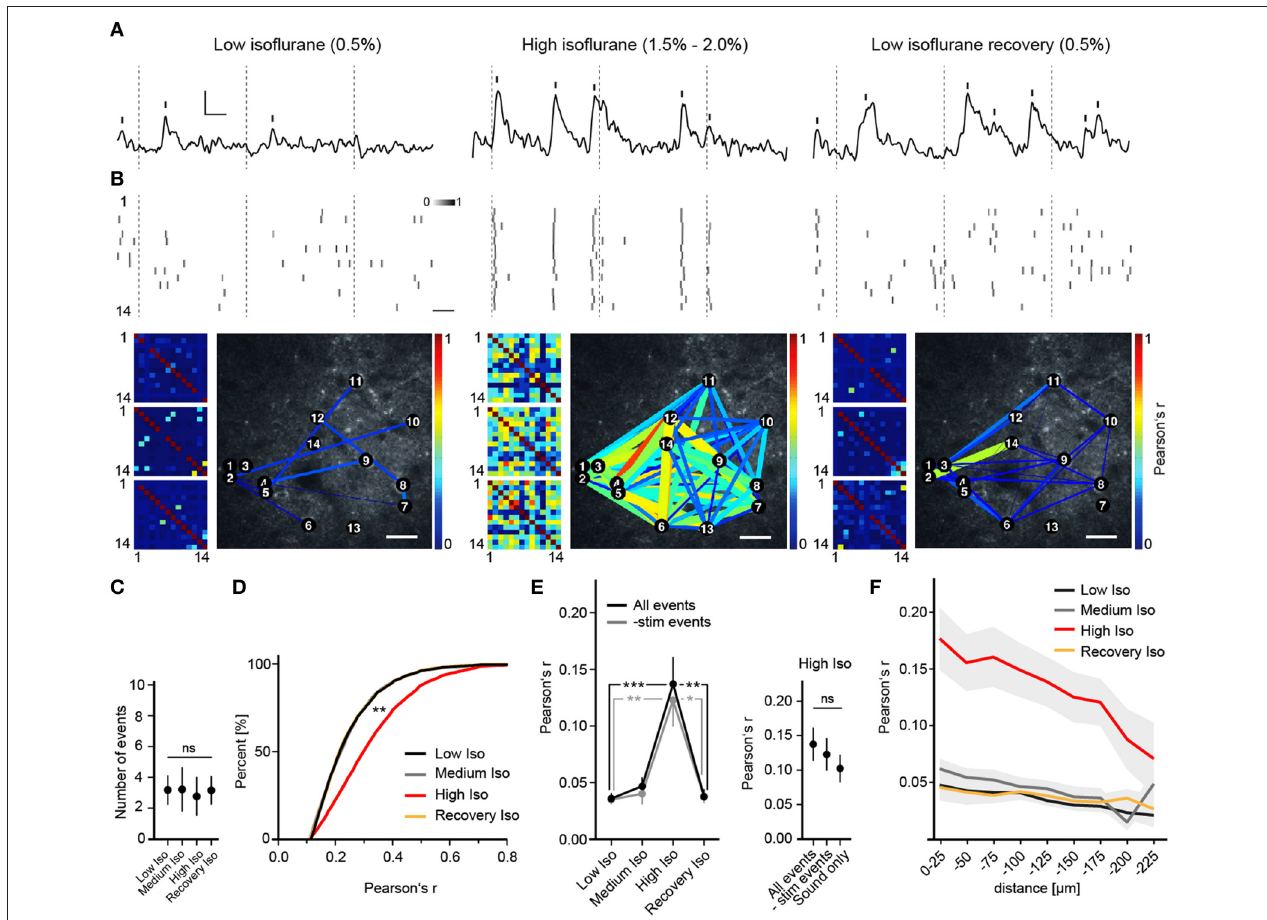
FIGURE 2 | Deep anesthesia enhances neural synchrony. (A) Random example fluorescence traces of the same cell under different anesthetic conditions. Vertical bars mark detected peaks, inset: 5% ∆ R/R (y-axis), 5s (x-axis). (B) Extracted peak time points of all cells shown as probabilities over adjacent frames ( Top panel, scale bar: 5s), color-coded correlation matrices for Pearson’s r of 3 example trials ( Bottom panel, small pictures) and example correlation maps ( Bottom panel, big pictures, scale bar: 30 µ m). Inset: color-code for peak probability (white = 0 to black = 1). Dotted lines indicate time points of whisker stimulation. Correlation is expressed as Pearson’s correlation coefficient (r) and color-coded from r = 0 (blue, no correlation) to r = 1 (red, perfect positive correlation). (C) The number of detected peaks per cell (mean over all trials and cells ± SD; ANOVA, p = 0.71). (D) Correlation r’s filtered for significance ( p < 0.05) shift toward higher values with high isoflurane: cumulative frequency distribution for all pairwise correlation r’s ( p < 0.01 High Iso vs. Low Iso). (E) High isoflurane concentrations induce a marked increase in overall synchrony that is independent of sensory stimulation. (Left) Mean pairwise correlation of all cell pairs for the indicated isoflurane concentration over all trials per mouse (mean ± SEM, * p < 0.05, ** p < 0.01 *** p < 0.001). (Right) Summary of correlation r -values under a high isoflurane concentration (mean ± SEM). The same analysis as above was additionally performed for trials where only auditory stimulation was present (All peaks vs. subtracted p = 0.58, All peaks vs. Sound only; p = 0.43). (F) High isoflurane concentrations preferentially increase synchrony between nearby neurons. Shown is the mean pairwise correlation (Pearson’s r) plotted against pairwise distance (bin size: 25 µ m) (mean ±